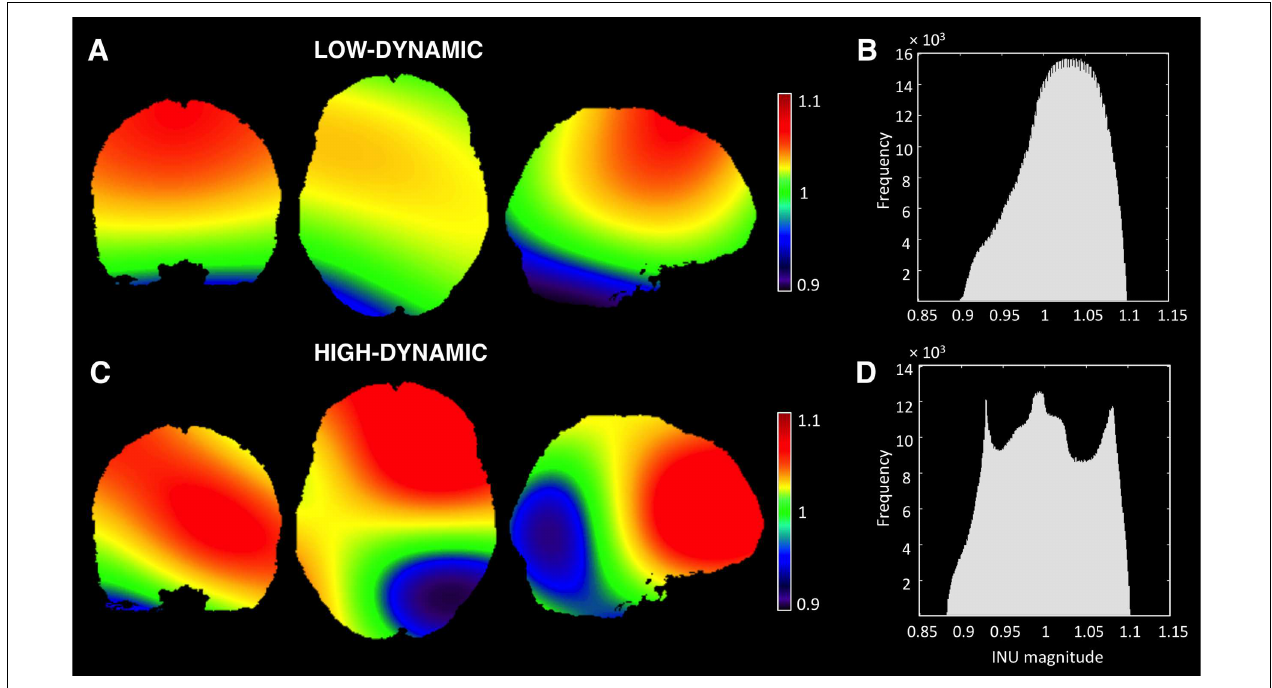
FIGURE 2 | Simulated INU fields. Spatial profiles and histograms of the low-dynamic (A,B) and the high-dynamic INU fields (C,D) at 20% level are represented. Both INU fields are displayed in coronal ( y = 1), axial ( z = 0), and sagittal ( x = 15) sections. It is worth noting that the INU fields at 40 and 80% level are characterized by the same spatial profile of the one at 20%, whereas the field values range from 0.8 to 1.2 and from 0.6 to 1.4, respectively.